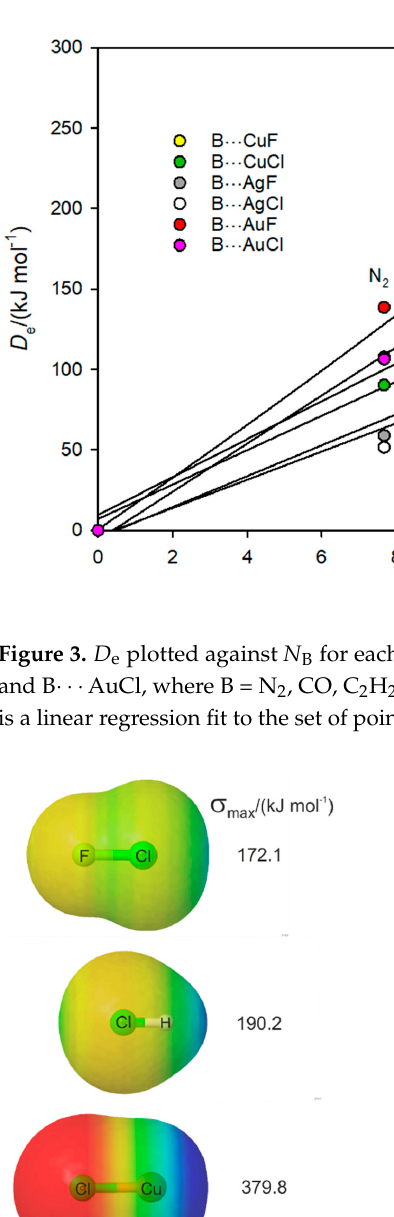
Figure 2. D e as calculated ab initio versus the values calculated from the nucleophilicity N B and electrophilicities E MX by Equation (2), D e = cN B . E MX .